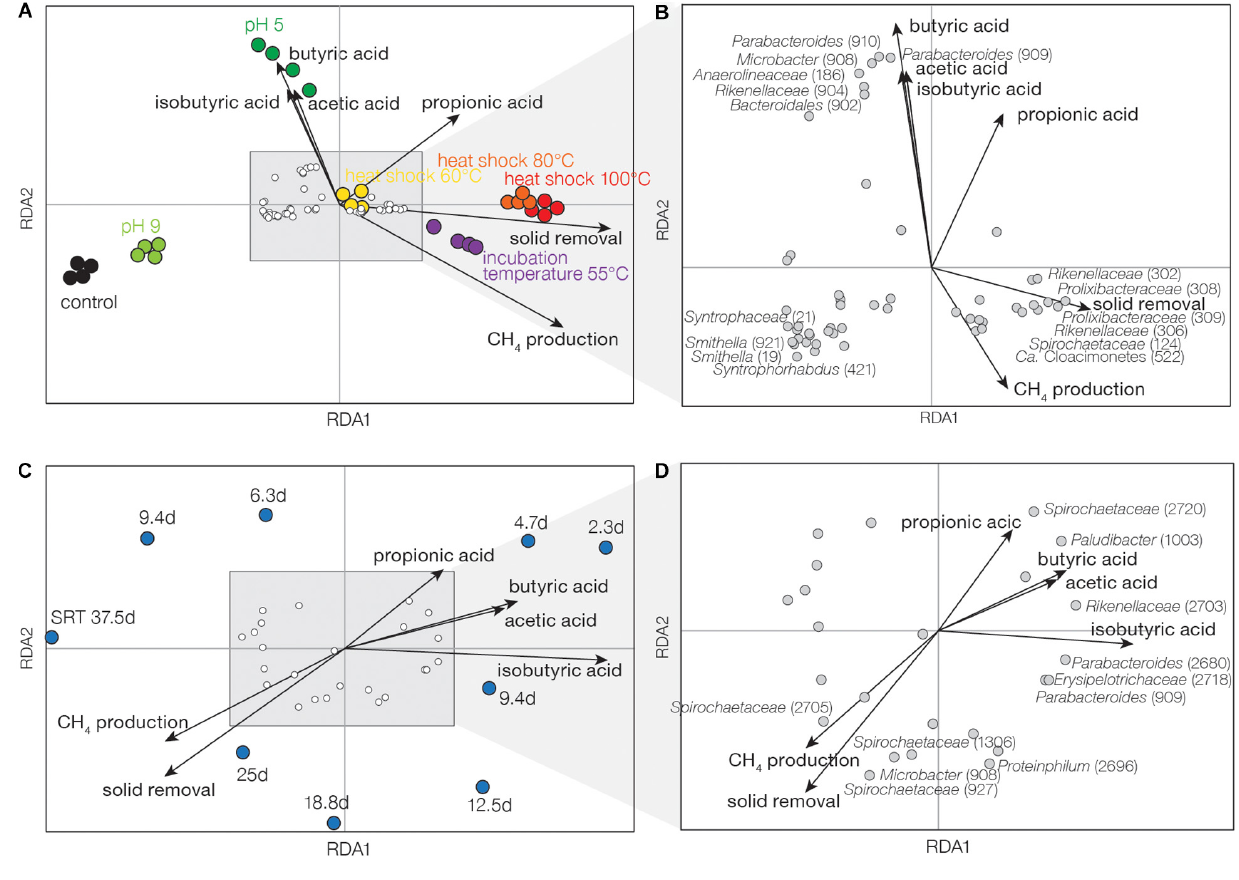
FIGURE 4 | Redundancy analysis based on active and dominant OTUs of (A,B) experiment I and (C,D) experiment II. (A,C) are tri-plots of entire communities, OTUs, and performance data. (B,D) are zoomed in plots of OTUs and performance data. Length and direction of arrows indicate the strength and intensity of the performance data. OTU ID is